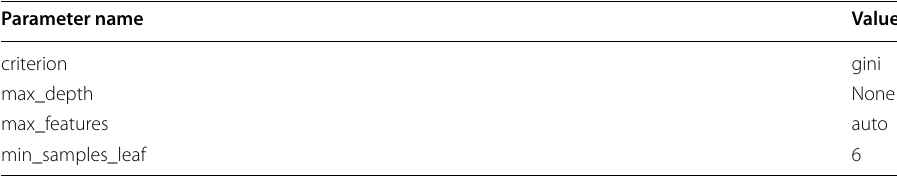
Table 88 Modes of DT tuned hyperparameter values for experiments with the data exfiltration dataset